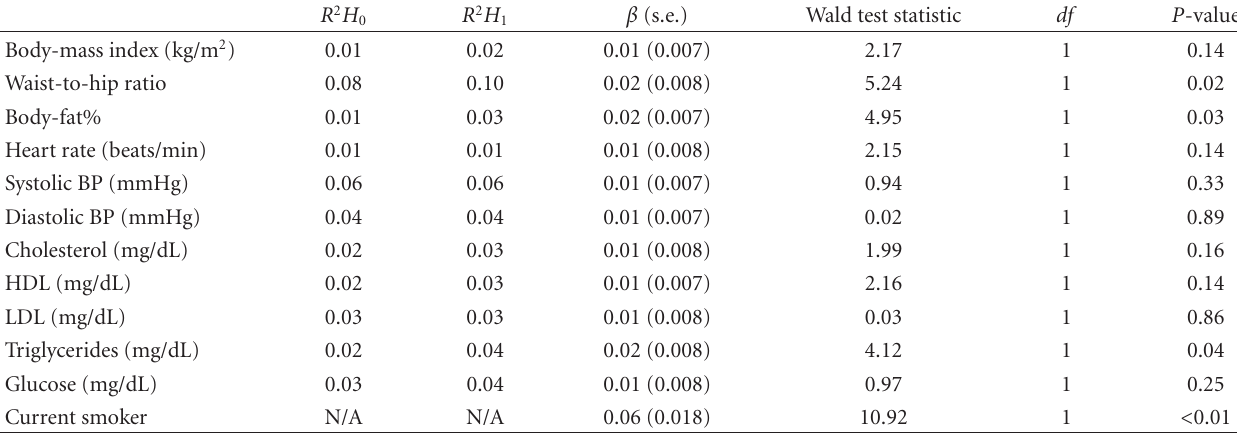
Table 3: Relationship between depressive symptoms and traditional CVD risk factors while controlling for socioeconomic